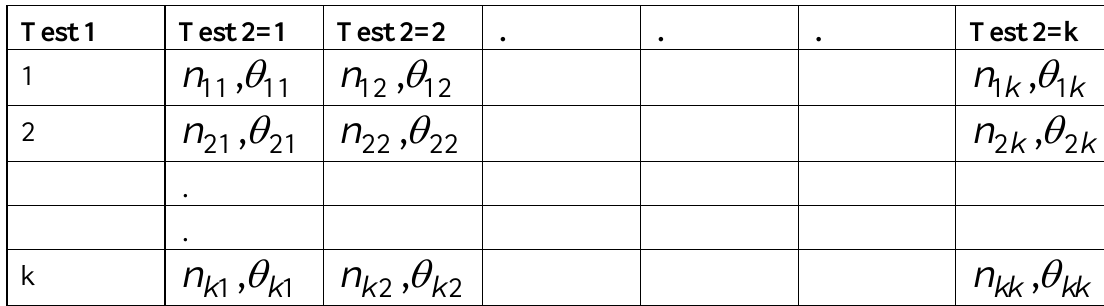
Table 26. (a) Two medical tests for diseased patients: frequencies and probabilities; (b) two medical tests for non-diseased patients: frequencies and